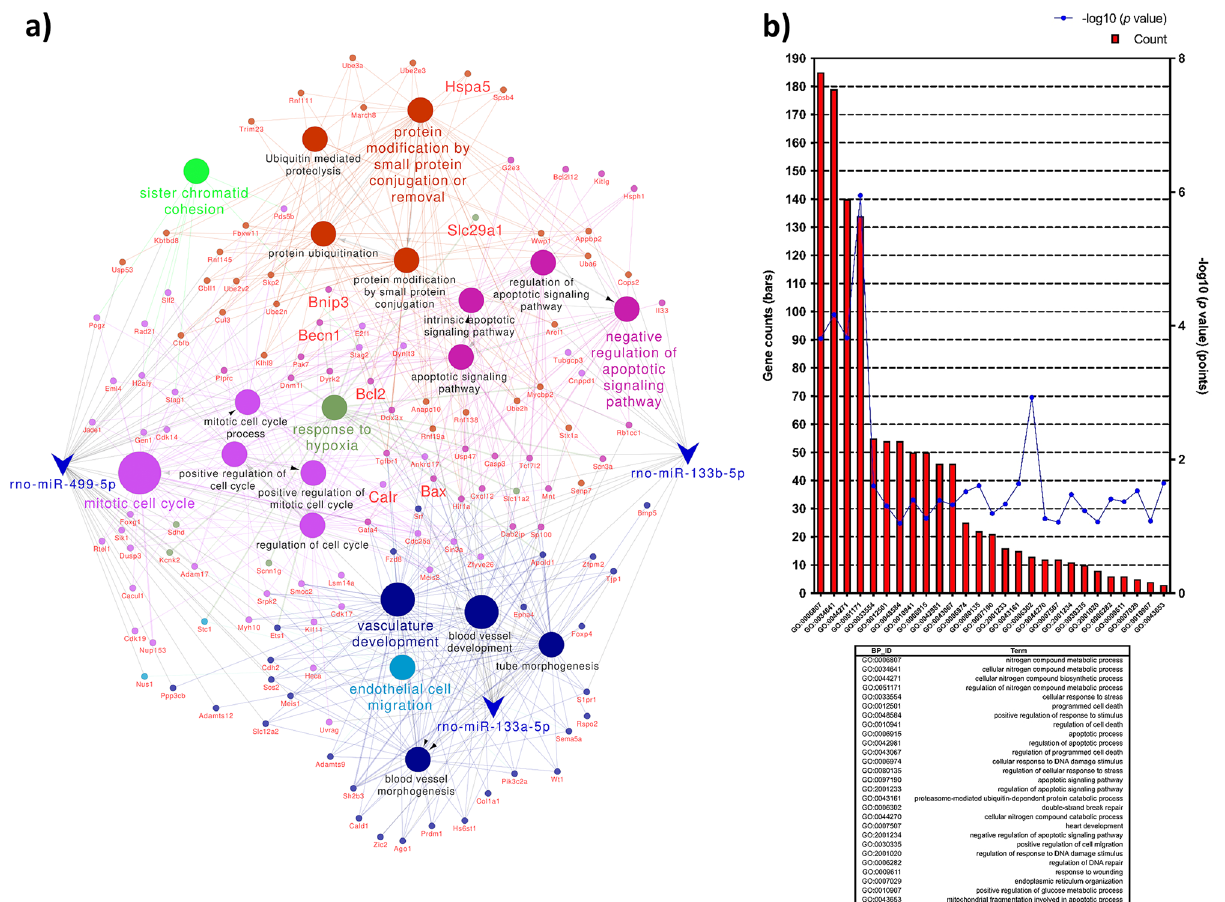
Figure 7. Verification of possible biological processes regulated by the examined miRNAs associated with the pathogenesis of diabetic cardiomyopathy and representative GO-enriched functional annotations for the predicted targets of miRNAs from DAVID. ( a ) The 268 common genes with predicted targets of rno-miR- 499-5p, rno-miR-133a-5p, and rno-miR-133b-5p were used to construct miRNA-mRNA regulatory network visualized in Cytoscape. Functional annotation map for the constructed regulatory network was created using ClueGO precompiled source files from GO BP and KEGG databases 18 . ( b ) Database for Annotation, Visualization, and Integrated Discovery (DAVID; v6.8; https:// david. ncifc rf. gov) online tool was used to determine the BP attributes of GO for the candidate target genes of miR-499, miR-133a, and mir-133b. GO terms with modified Fisher exact p-value (EASE score) ≤ 0.1, FDR < 0.1, and N per group > 3 were considered strongly